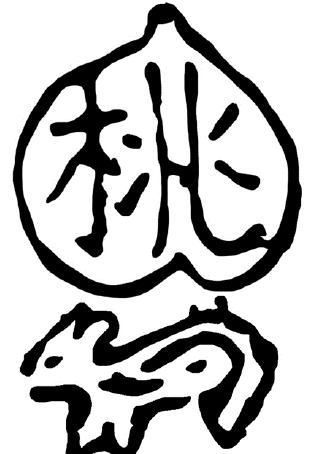
Figure 13. A Song Yuan Huaya with a peach inscribed with a Chinese character “Tao 桃 (Peach)” on the back of a hare. The period of the Song and Yuan Dynasties. Sketched by author. Picture source: Shi (1995), p. 58.